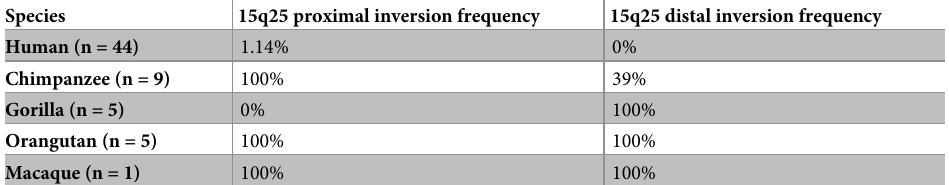
Table 1. Summary of inversion frequencies in human and nonhuman primates. Inversion frequencies for the prox- imal and distal region based on FISH, Strand-seq and optical mapping analyses are shown. The number of individuals tested for each species is shown in